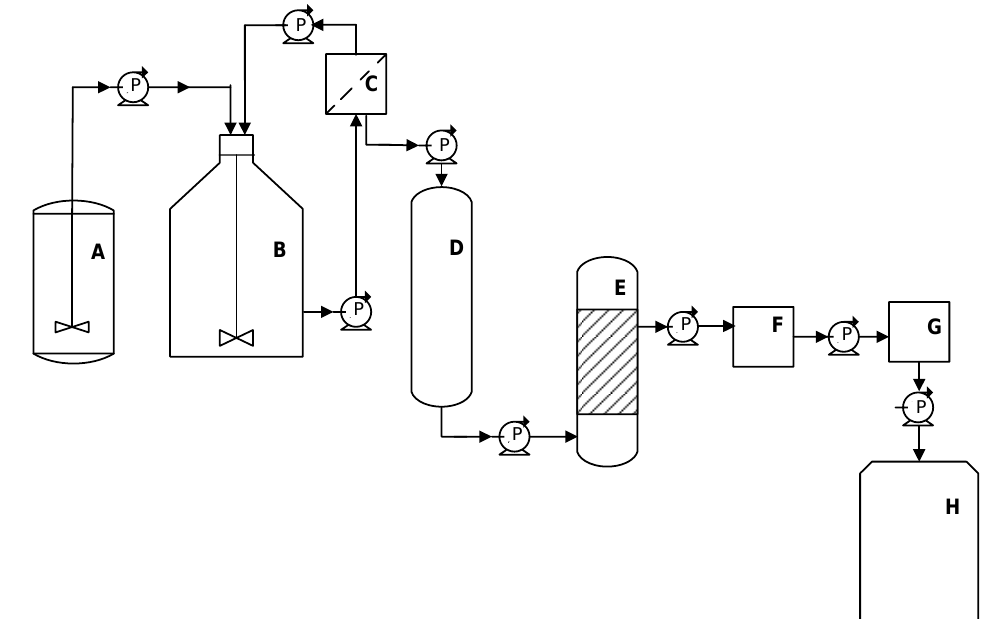
Figure 11. The schematic diagram of continuous lactic acid production with enzyme and cell recycling by ultrafiltration coupled with granulated active charcoal and chelating resin columns and a two-stage electrodialysis. A: Feed vessel containing fresh media/nutrients; B: Anaerobic bioreactor containing lignocellulose hydrolyzate (before enzymatic hydrolysis), substrate (e.g., glucose obtained after enzymatic hydrolysis), enzyme(s), inoculum and media; C: Ultrafiltration membrane; D: Granulated active charcoal column; E: Chelating resin column; F: Monopolar (convectional) electrodialysis; G: Bipolar electrodialysis; H: Permeate (lactic acid) vessel; and P: low/medium/high pump operated at different flow rates.